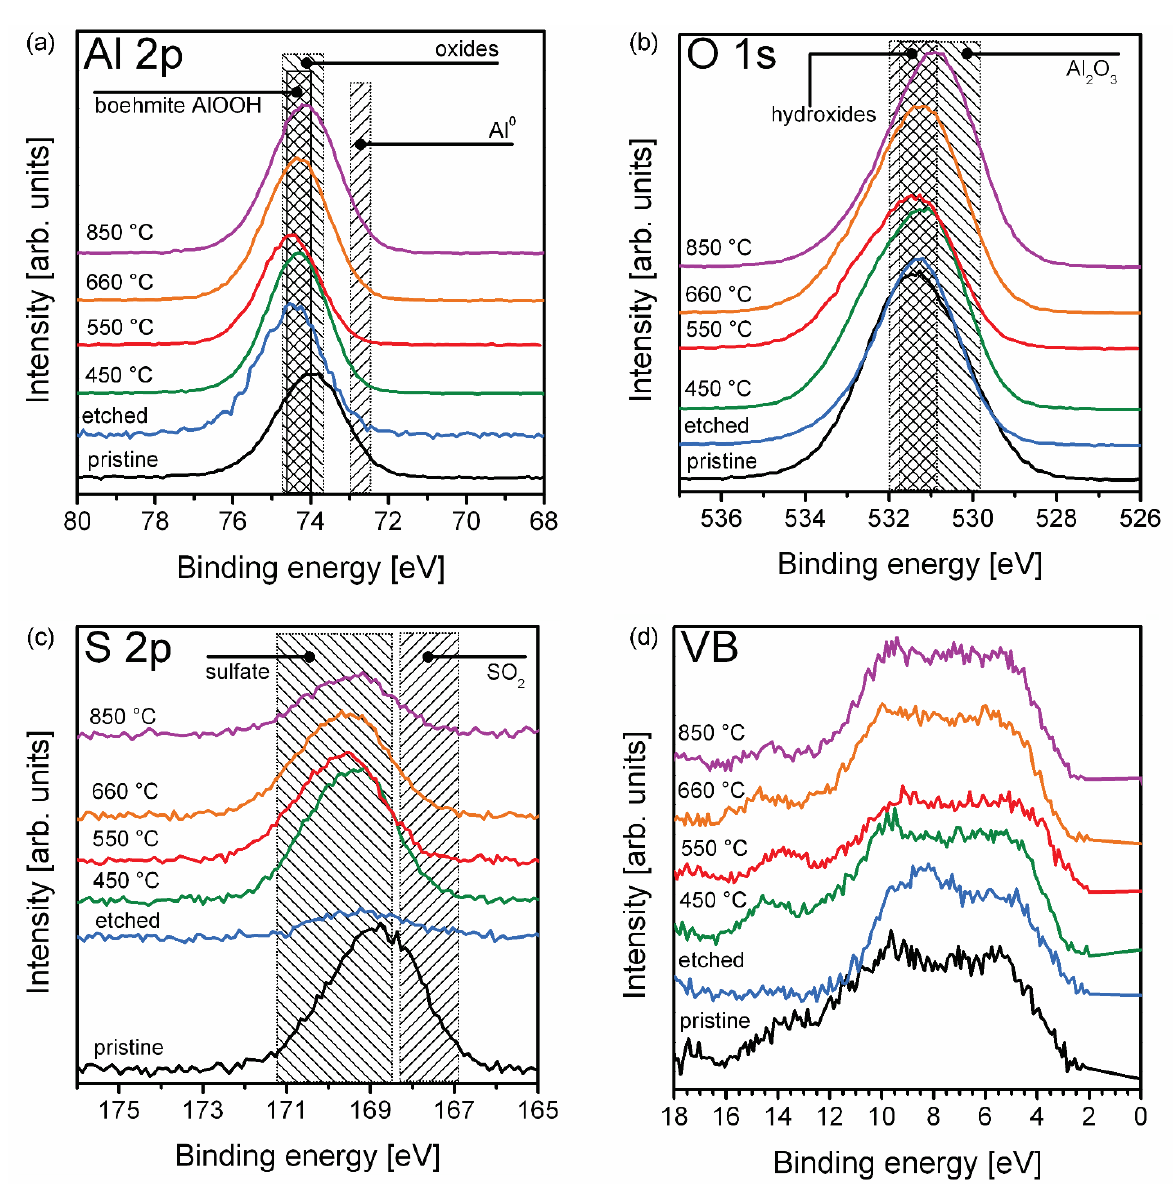
Figure 9. High-resolution Al 2p ( a )-, O 1s ( b )-, S 2p ( c )- and valence band ( d )- photoelectron spectra of a b-PAA sample calcined at different temperatures. Hatched areas correspond to the binding energy ranges characteristic for ( a ) hydrated boehmite AlOOH, anhydrous oxides, and metallic aluminum, ( b ) aluminum hydroxides and anhydrous stoichiometric oxides, ( c ) sulfate anions and sulfur dioxide.